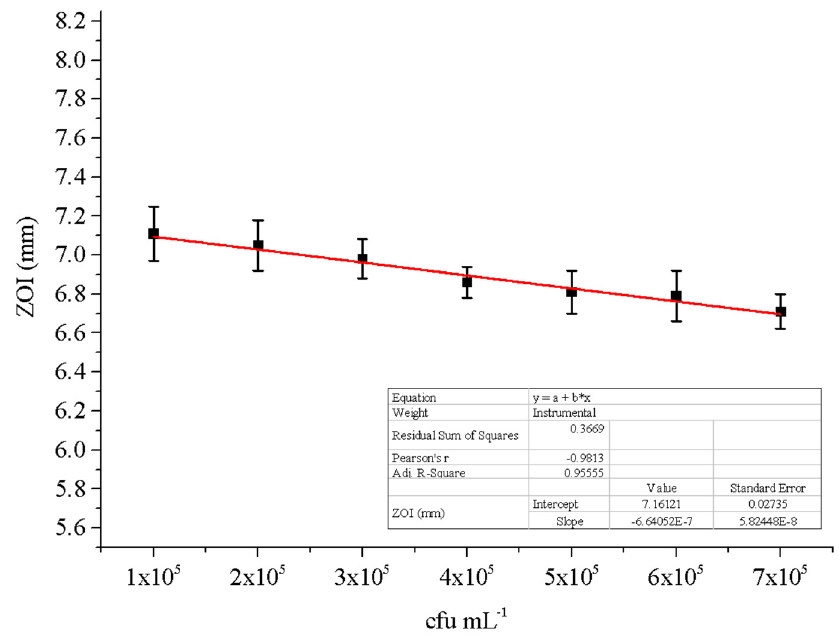
Figure 4. The effect of cfu mL − 1 on the ZOI of MRSE at 150 mg L − 1 of rosin maleic anhydride nanoparticles, after incubation at 35 °C for 24 h.